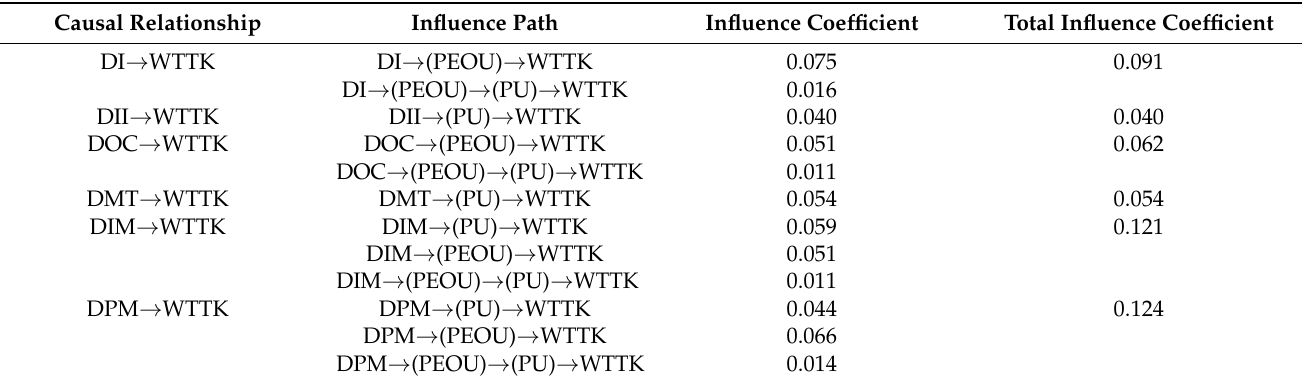
Table 7. Results of mediating